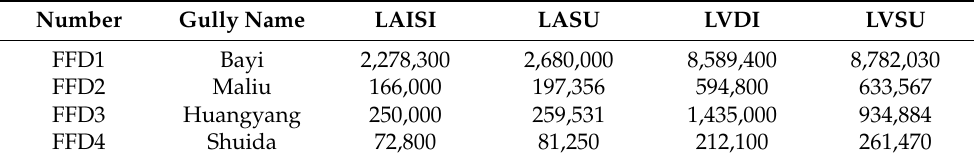
Table 4. Statistics of landslide area by interpretation satellite images (LAISI) (m 2 ), landslide area by slope-units (LASU) (m 2 ), landslide volume by post-disaster investigation (LVDI) (m 3 ), landslide vol- ume by slope-units (LVSU) (m 3 ).